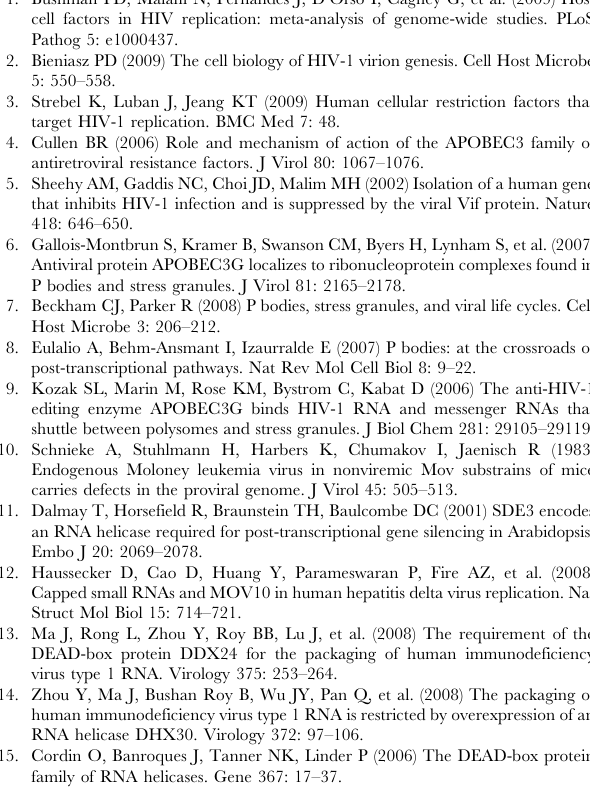
Figure S2 HIV-1 produced in cells stably expressing Mov10 is less infectious. 293T cells were stably transfected with a vector expressing Mov10 and selected with 0.5 mg/ml G418. When these cells were subsequently transfected with an HIV-1 vector,